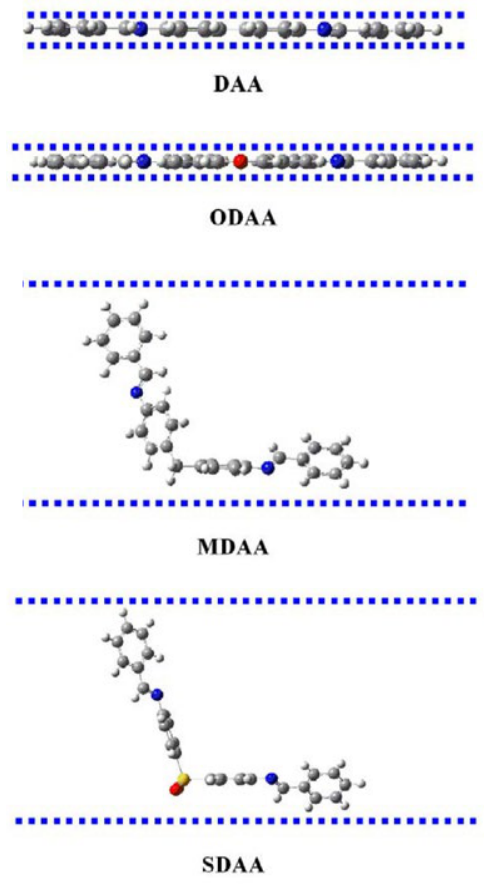
Figure 3: Geometry planarity of the studied dianiline Schiff